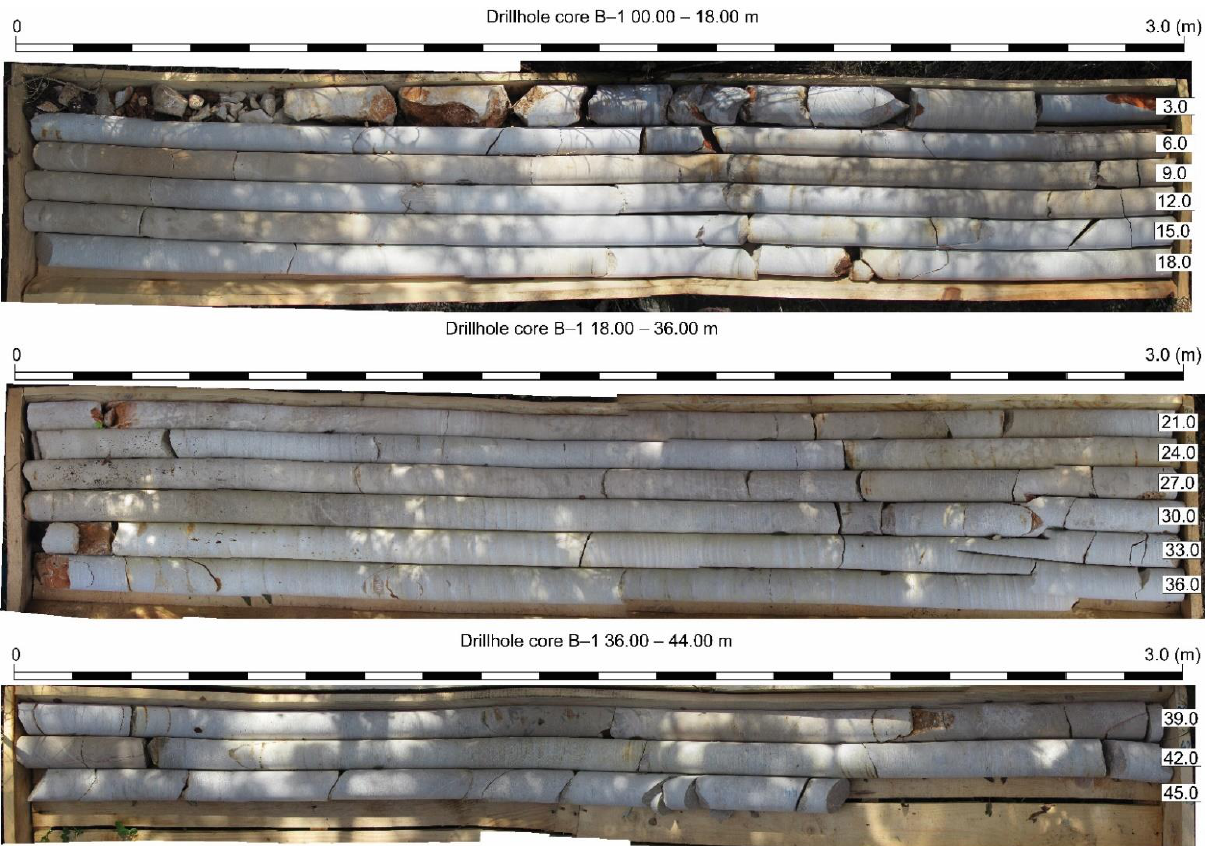
Figure 3. Example of drill hole core B-1.